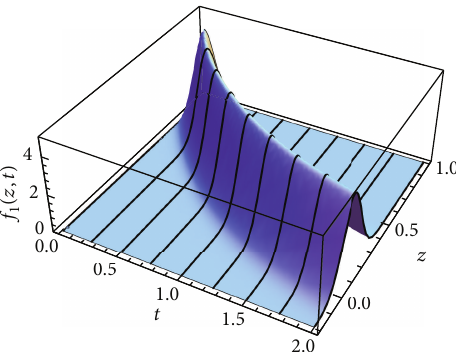
Figure 11: Plot of 𝑓 1 (𝑧, 𝑡) given by (113)-(114) in Example 21 at different values of 𝑡 = {0, 0.25, 0.5, . .. ,2} in the case that 𝜂 = , 𝐵) 𝑇 ∼ 𝑁(𝜇 ,Σ ) where 𝜇 Σ (𝑍 0 𝜂 𝜂 𝜂 and 𝜂 aregivenby (112)with = 0 , 𝜎 = 0.1 , 𝜎 = 0.1 , 𝜌 = 0.5 , 𝑡 = 0 , and 𝑎 = −1 . 𝜇 𝐵 𝑍 0 𝐵 𝑍 0 𝐵 0